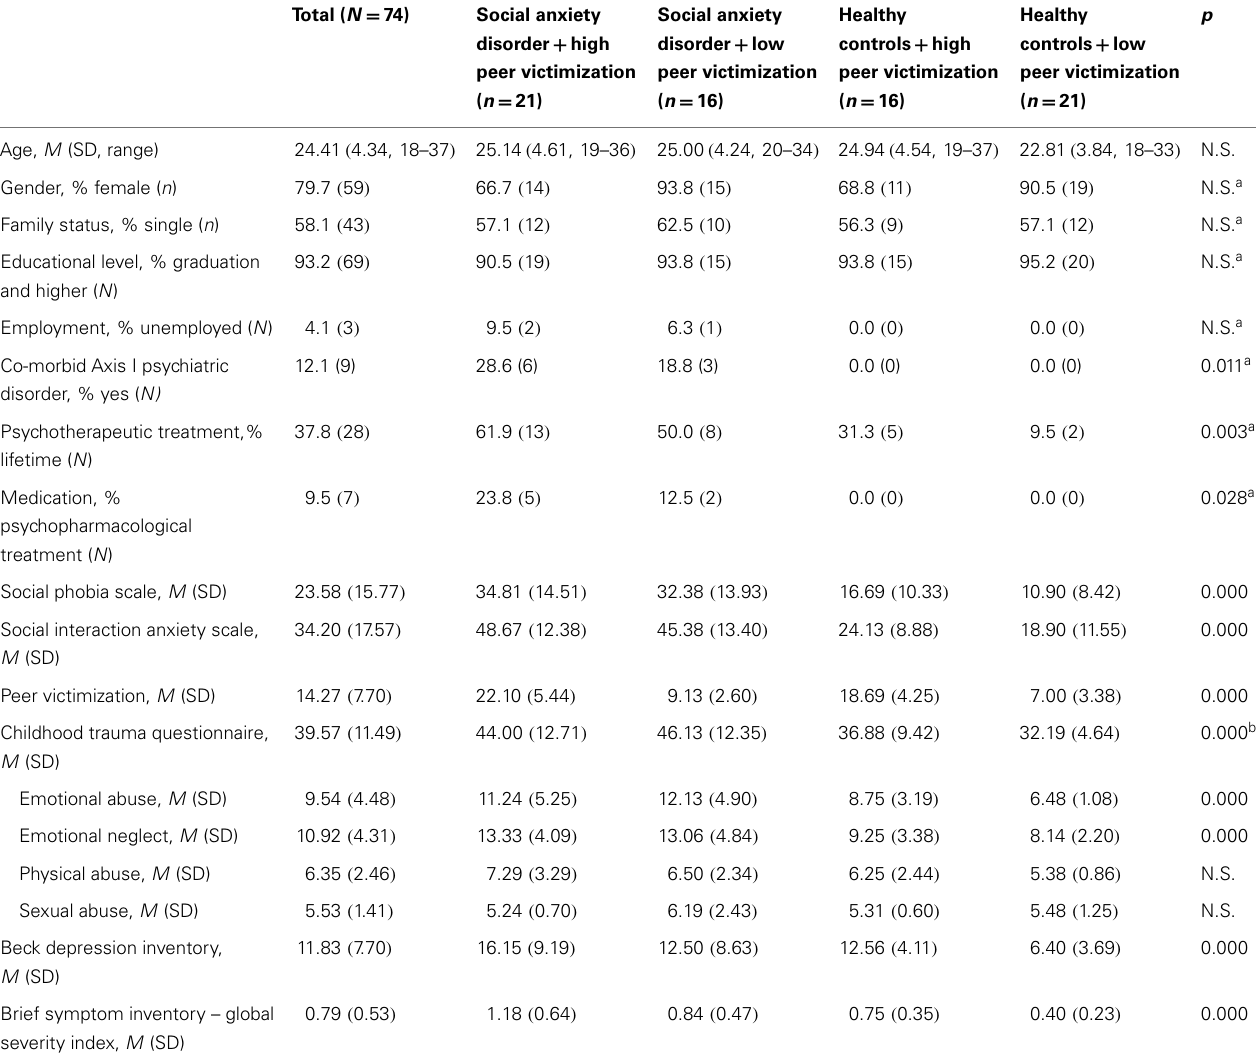
Table 1 | Subject characteristics and mean values on the assessments ( N =